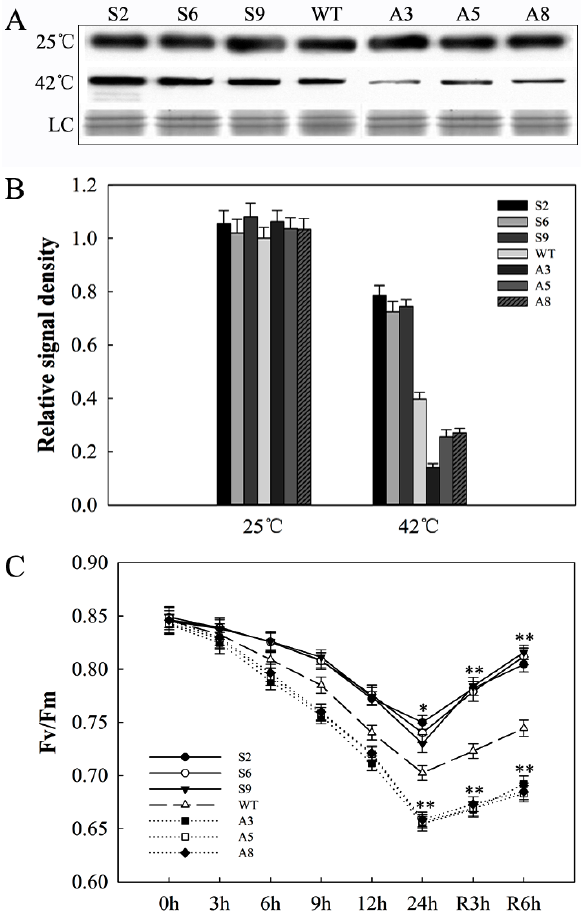
Figure 9. Changes in D1 protein levels and fluorescence (Fv/Fm) in WT and transgenic plants under heat stress. ( A ) D1 protein content. LC, loading control (part of a Coomassie-stained thylakoid membrane protein SDS polyacrylamide gel). ( B ) Image quantification of protein contents in ( B ). ( C )